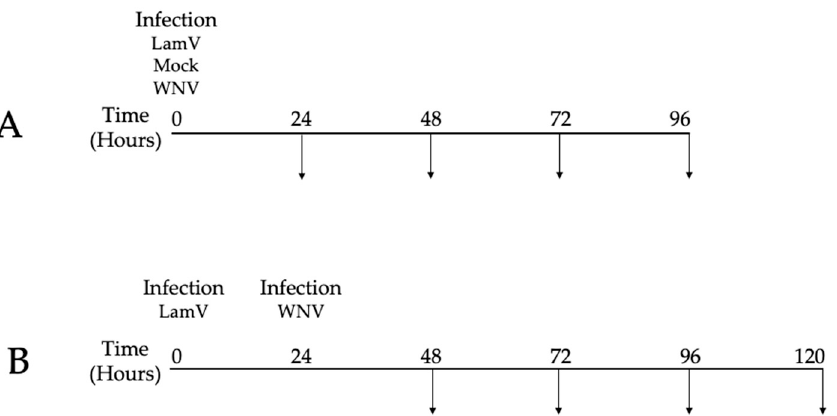
Figure 9. Schematic representation of the experiment schedule. ( A ) Time scheme for single infec- tions. ( B ) Time scheme for cells pre-infected with LamV and challenged with WNV. Arrows repre- sent sampling of cells and supernatant. Cells were only collected between the timepoints 24 to 72 hpi.